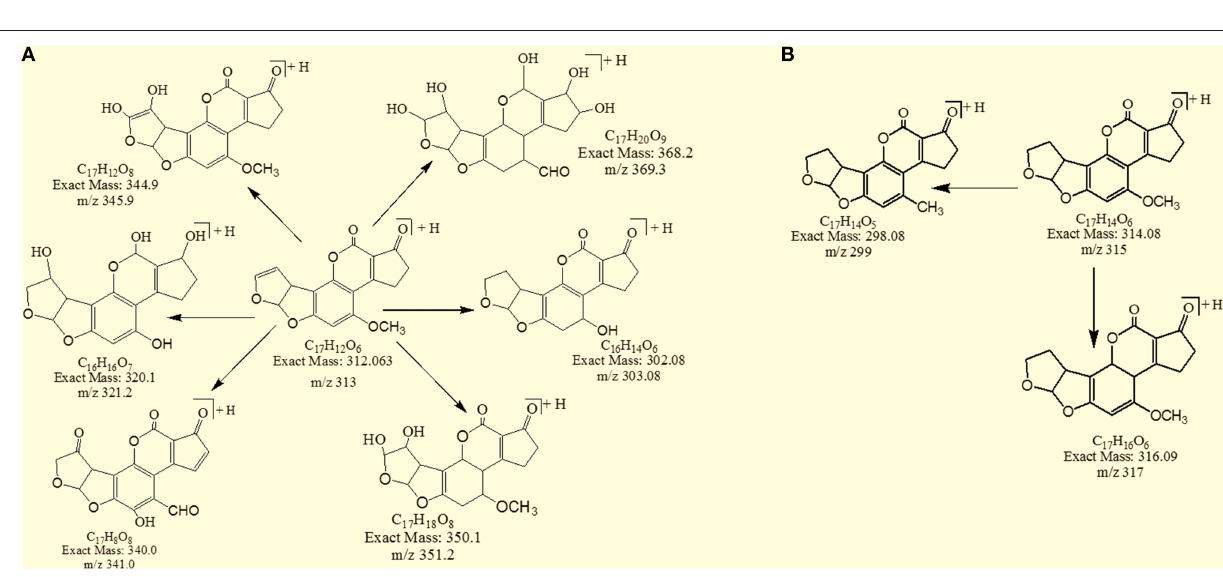
FIGURE 4 | Possible degraded products of (A) AFB1 and (B) AFB2 after treatment with T. ammi seeds extracts at 30 ◦ C and pH